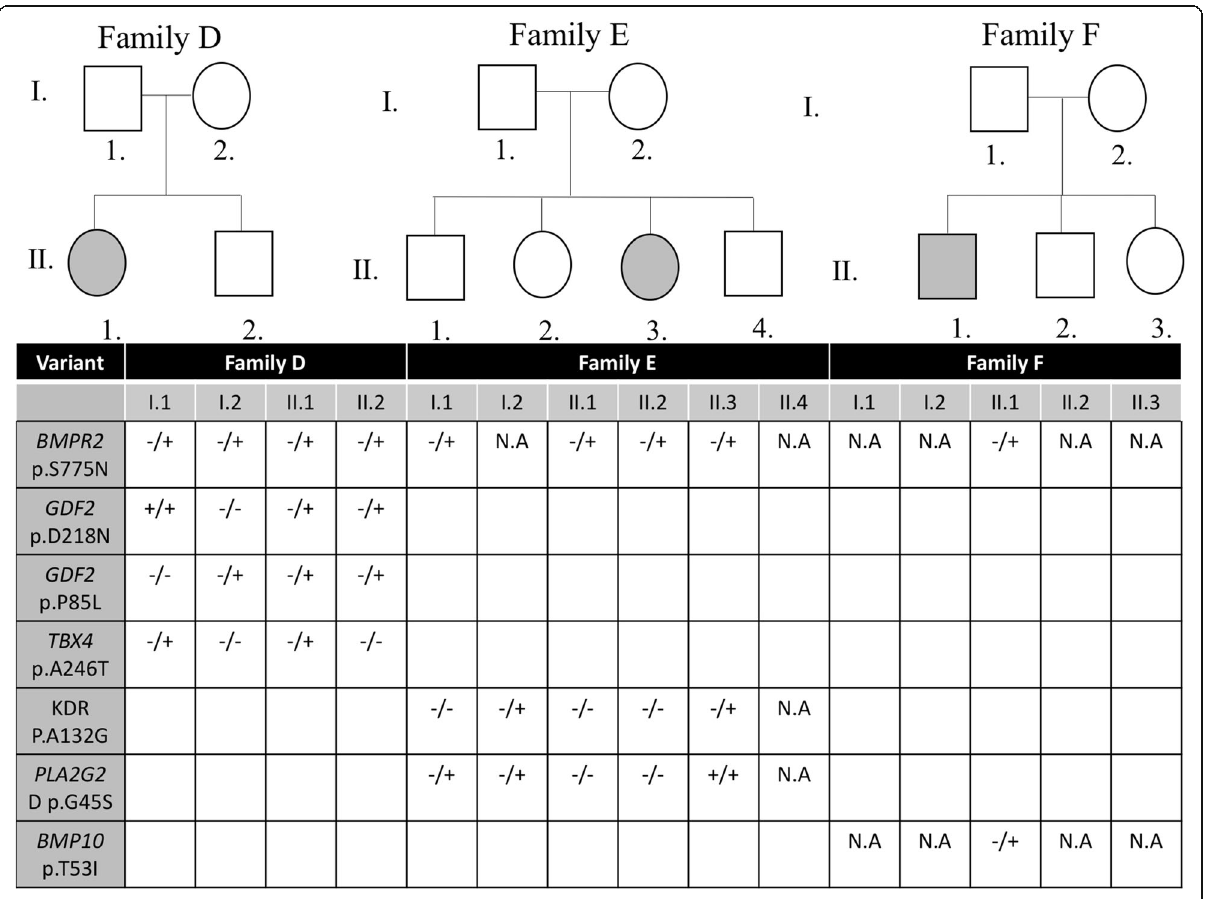
Fig. 3 Pedigrees for the p.S775 BMPR2 mutation in three families with the second hit mutations shown in the table. Square, Male; Circle, female; open symbol, unaffected; filled symbol, affected; symbol with diagonal line, dead individual; the − / − symbol is for normal genes, − /+ is for heterozygous mutations and the +/+ is for homozygous mutations. N/A stands for non-applicable because DNA is not